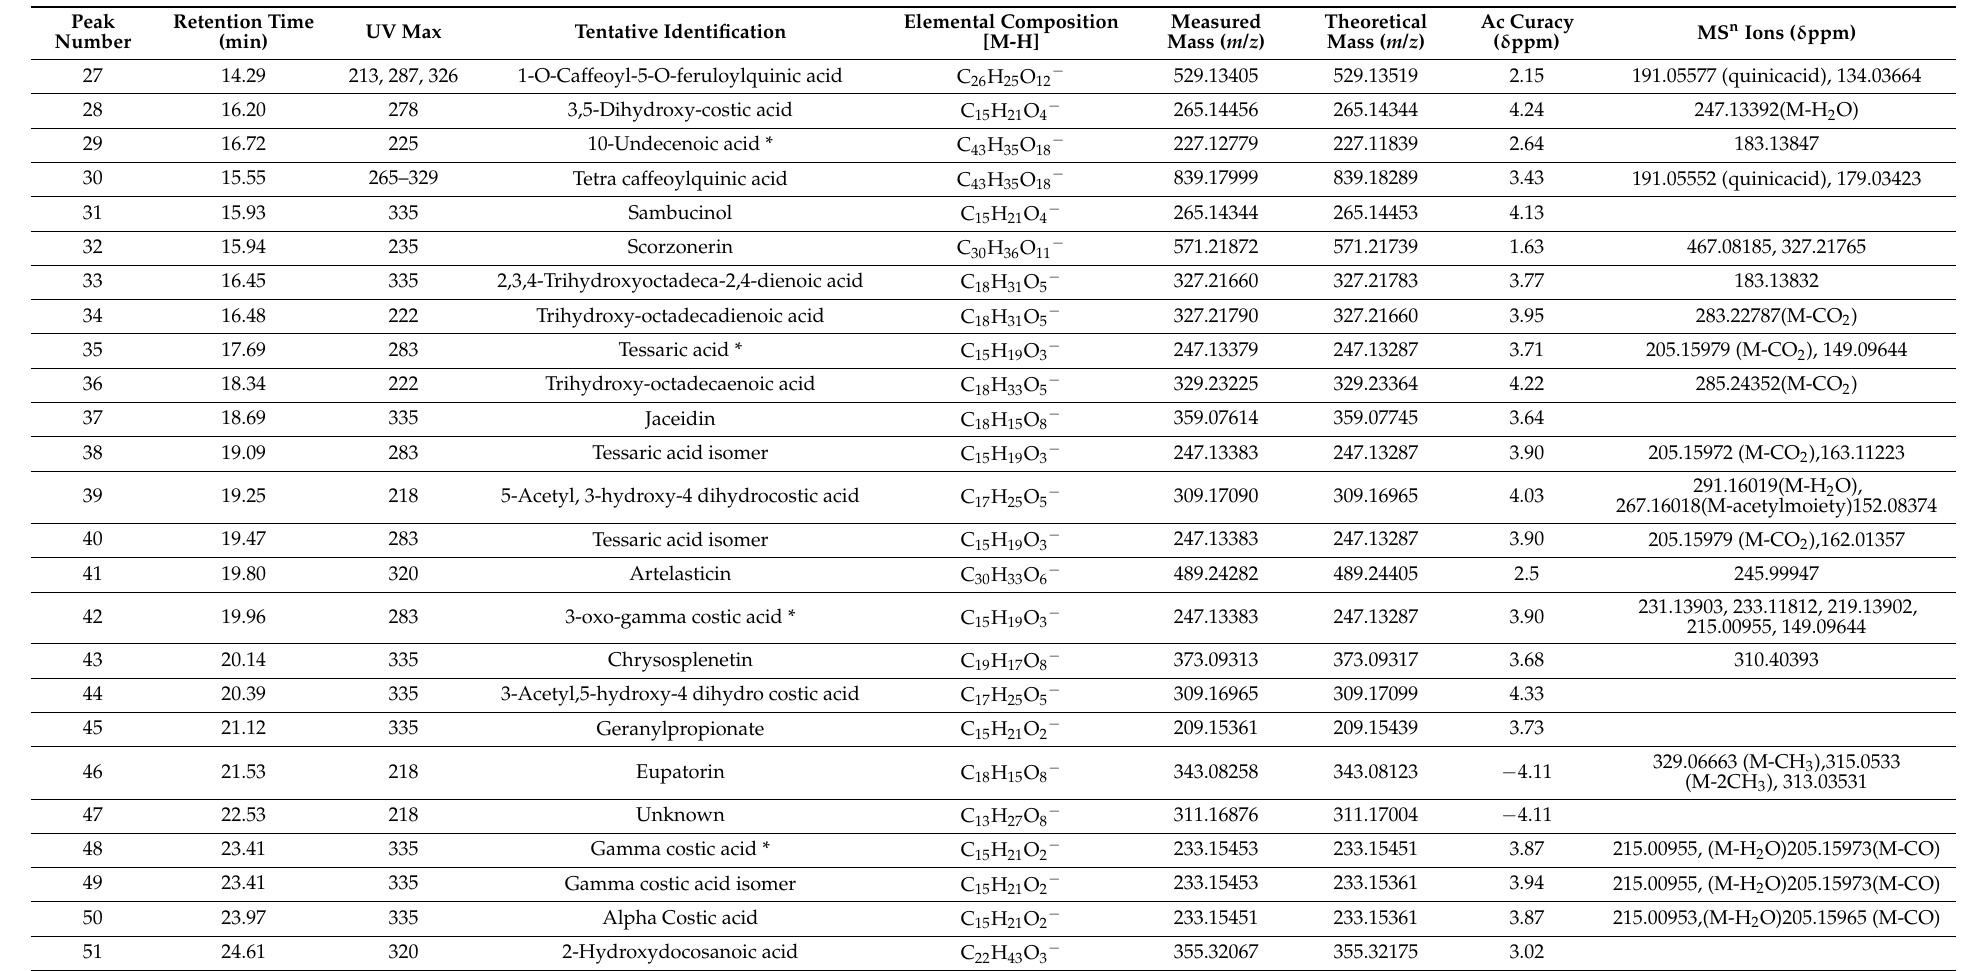
Table 2. High resolution UHPLC PDA-Q orbitrap identification of metabolites from